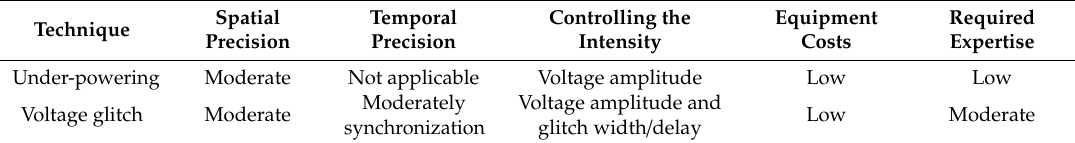
Table 2. Supply voltage fault injection techniques and characteristics.